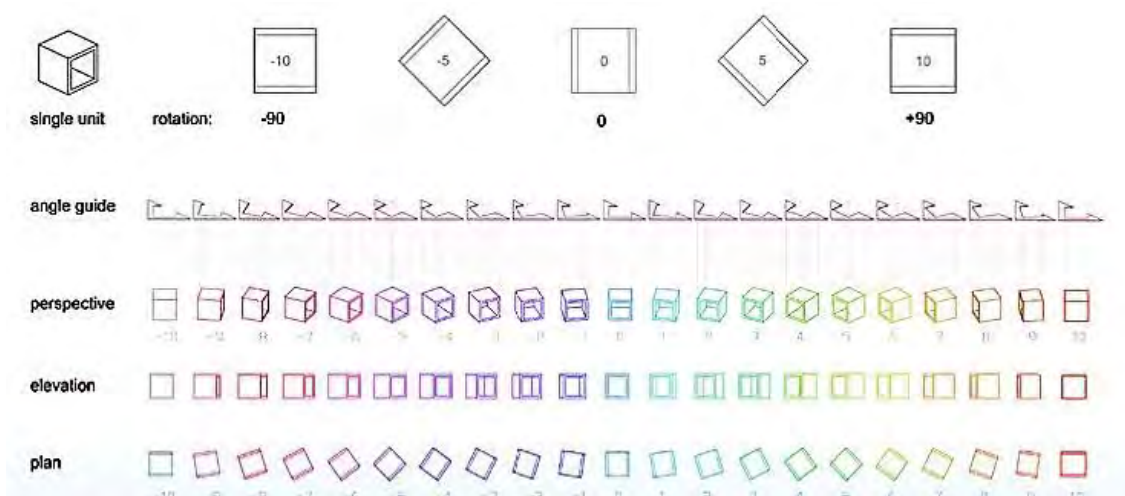
Figure 6. SilkWall. The angles of rotation of the cement blocks were constrained to 21values. Wooden formats were given by the architect to educate the manufacturershow to distribute the pieces to the right position.